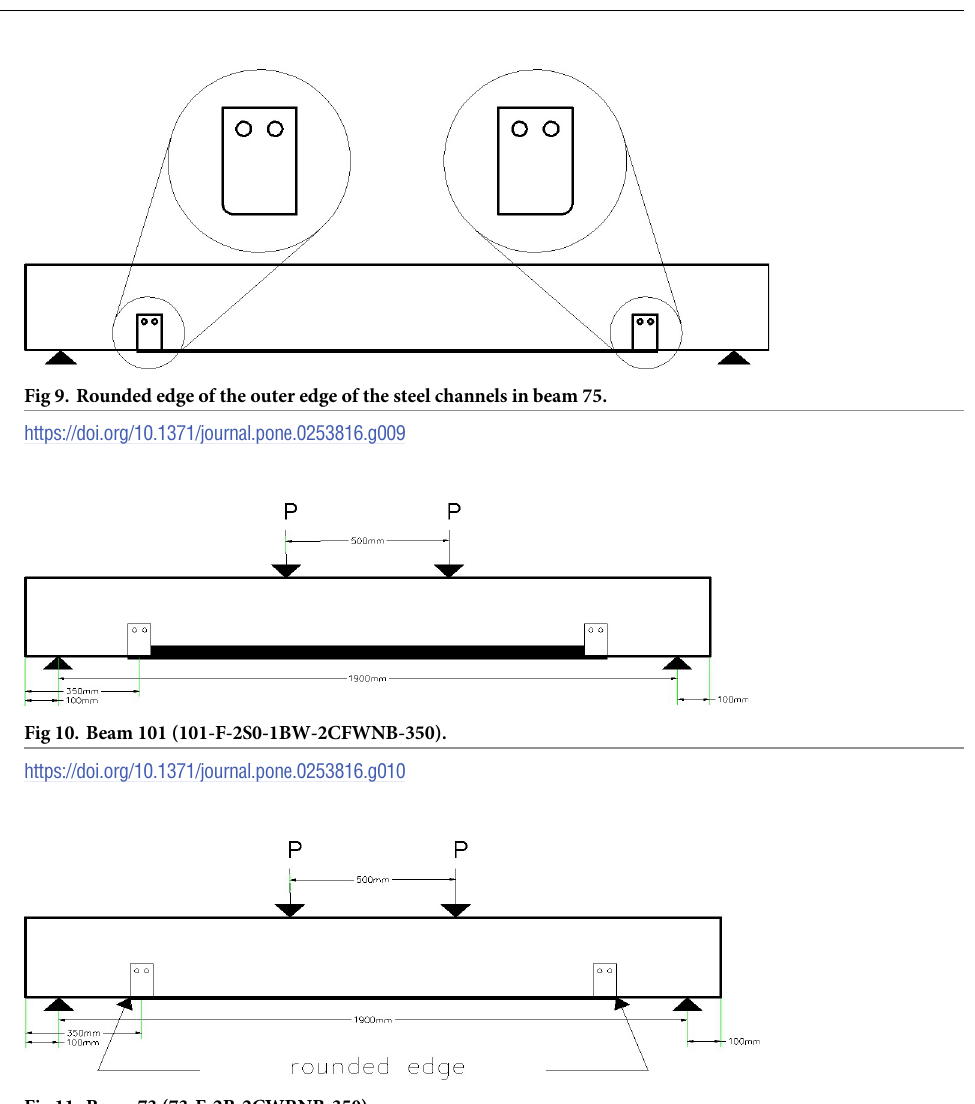
Fig 11. Beam 73 (73-F-2B-2CWRNB-350).